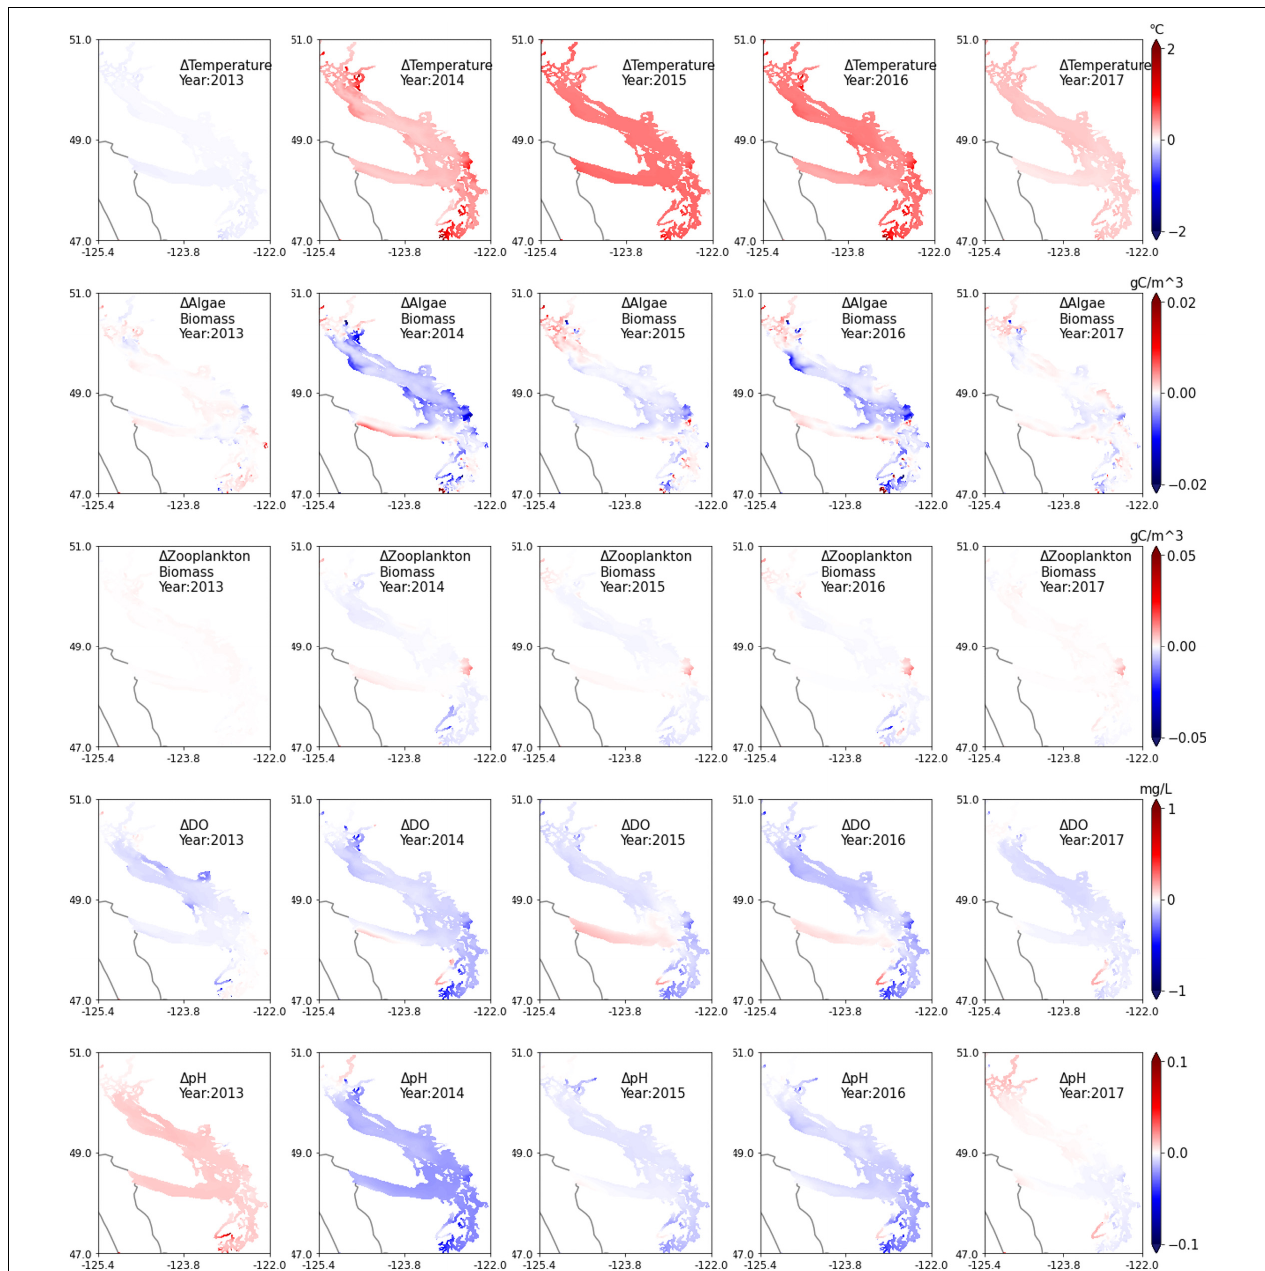
FIGURE 9 | Model biogeochemical response difference by year (algae and zooplankton biomass, DO, and pH) relative to reference conditions (without marine heatwave effects); depth-averaged contours with a focus on the Salish Sea. Years 2015 and 2016 represent the peak marine heatwave